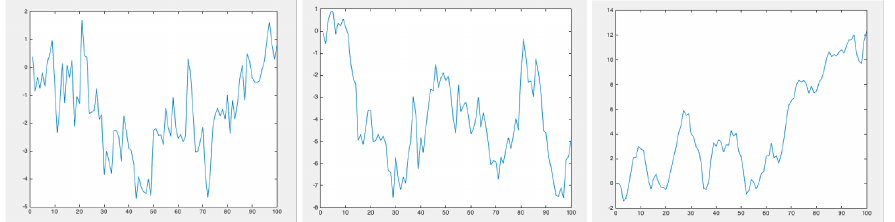
Figure 12. Profiles generated by a fractional Brownian motion characterized by H = 0.25 ( left ), H = 0.5 ( center ) and H = 0.75 ( right ).